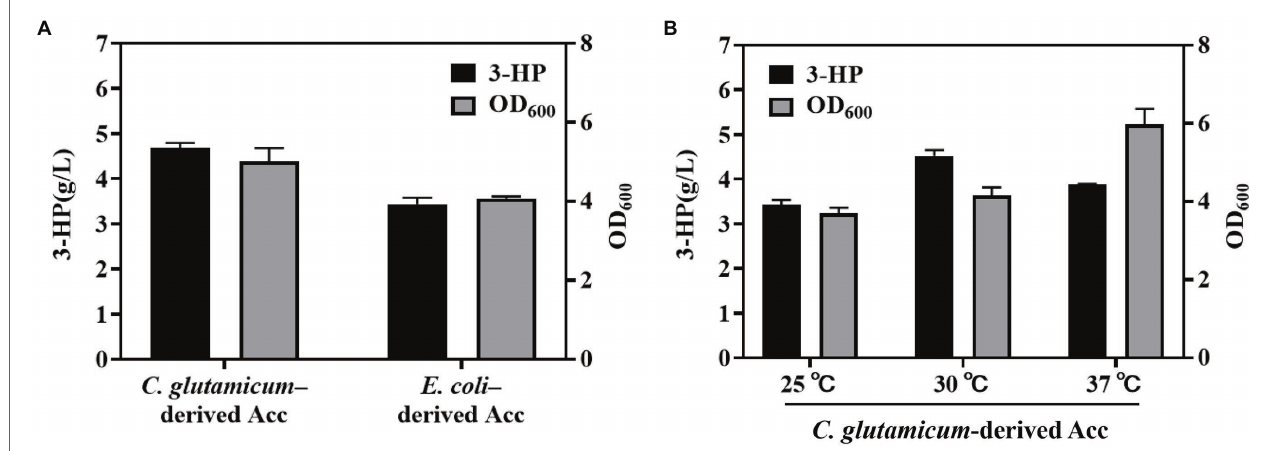
FIGURE 2 | Effect of Escherichia coli– and Corynebacterium glutamicum –derived Acc and temperature on 3-HP production. (A) Comparation of Corynebacterium glutamicum –derived Acc and Escherichia coli –derived Acc for 3-HP production and cell growth. (B) Studying the influence of various temperatures on 3-HP production with strain Corynebacterium glutamicum –derived Acc. The fermentation process was performed with a 300-mL shake-flask containing 50 ml of medium (shaken at 220 rpm for 48 h). Cultures were induced with 0.2 mM IPTG when OD 600 reached 0.6–0.8. All results were calculated with three ( n = 3) independent